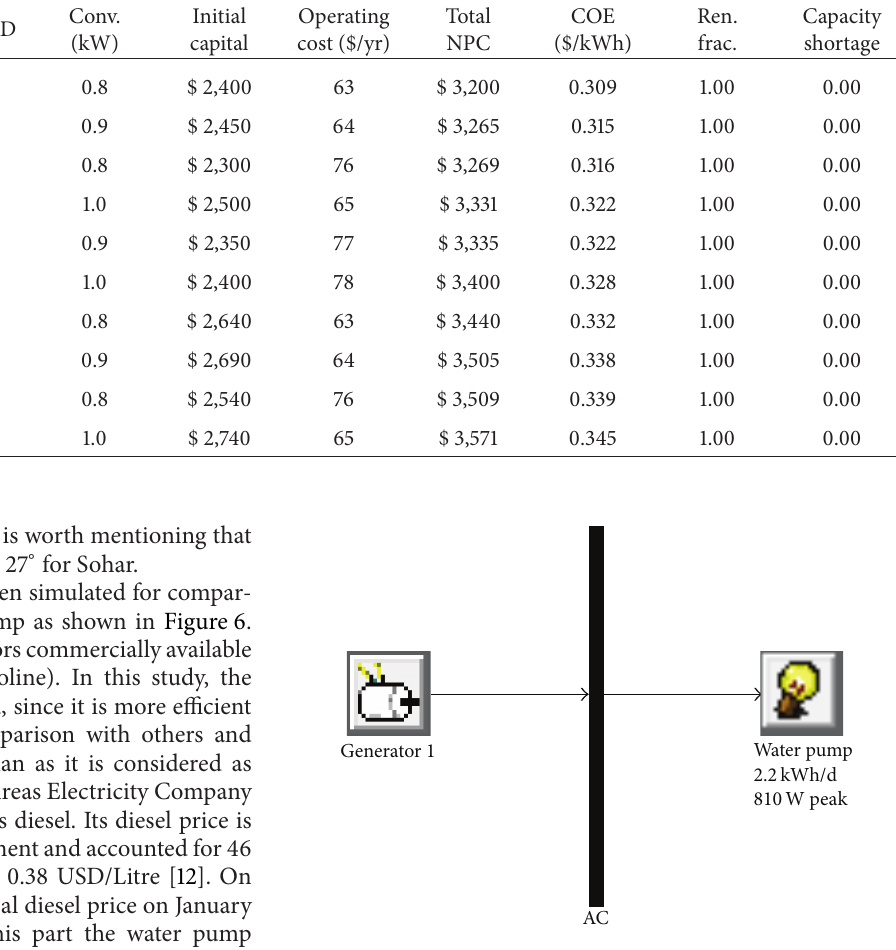
Figure 6: HOMER schematic diagrams for the diesel generator water pumping